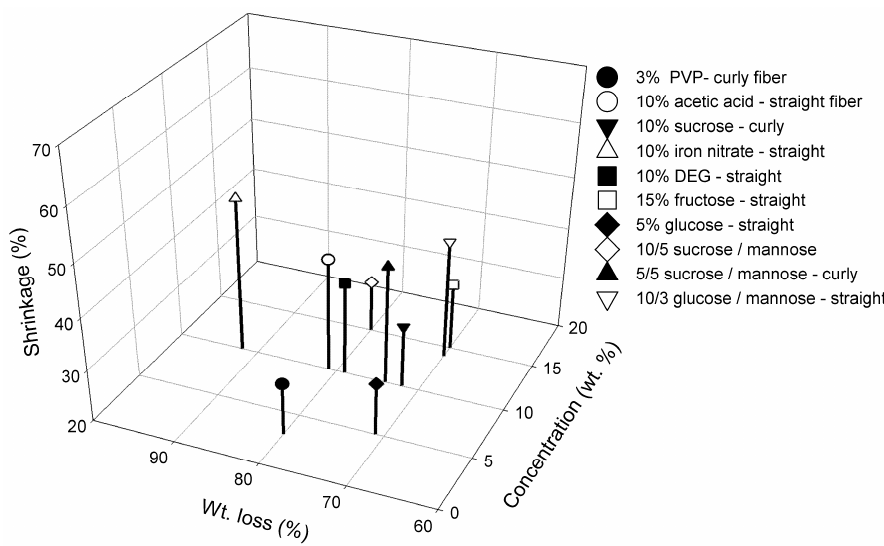
Figure A6. wt% loss and shrinkage after carbonization process when different additives were used after deacetylation.